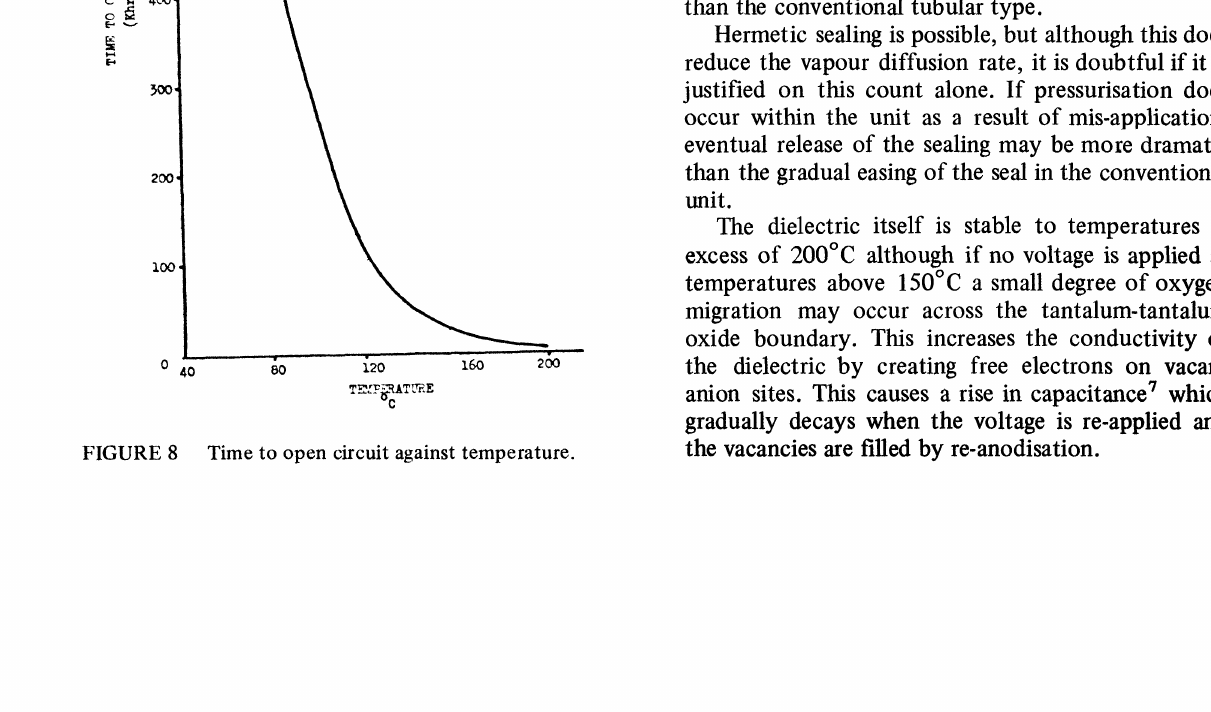
FIGURE 8 Time to open circuit against